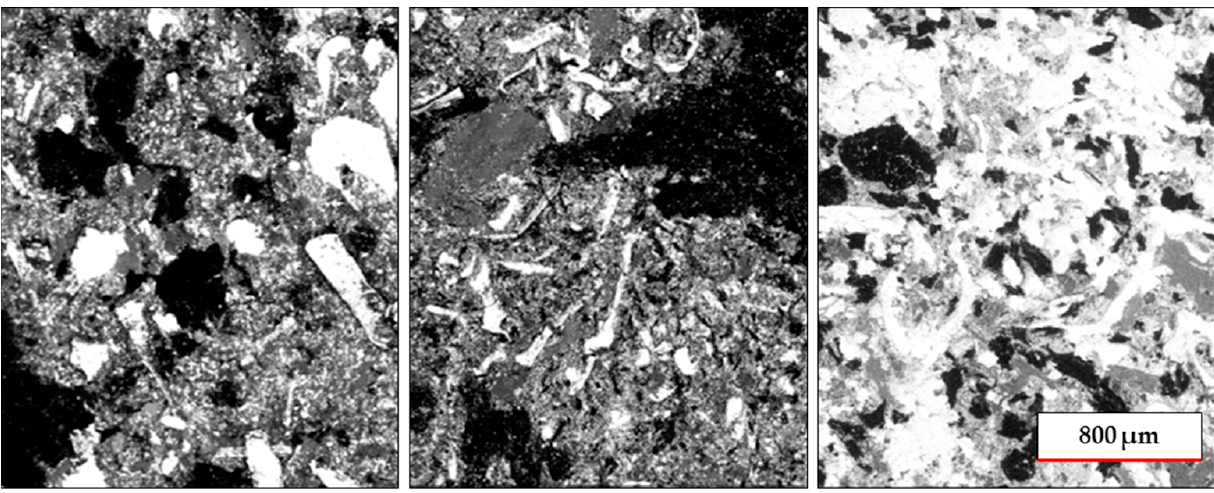
Figure 3. Comparison of friction materials—left: GCI (Grey Cast Iron) brake pad; centre: HMC (Hard Metal Coated) brake pad; right: CC (Carbon Ceramic) brake pad.